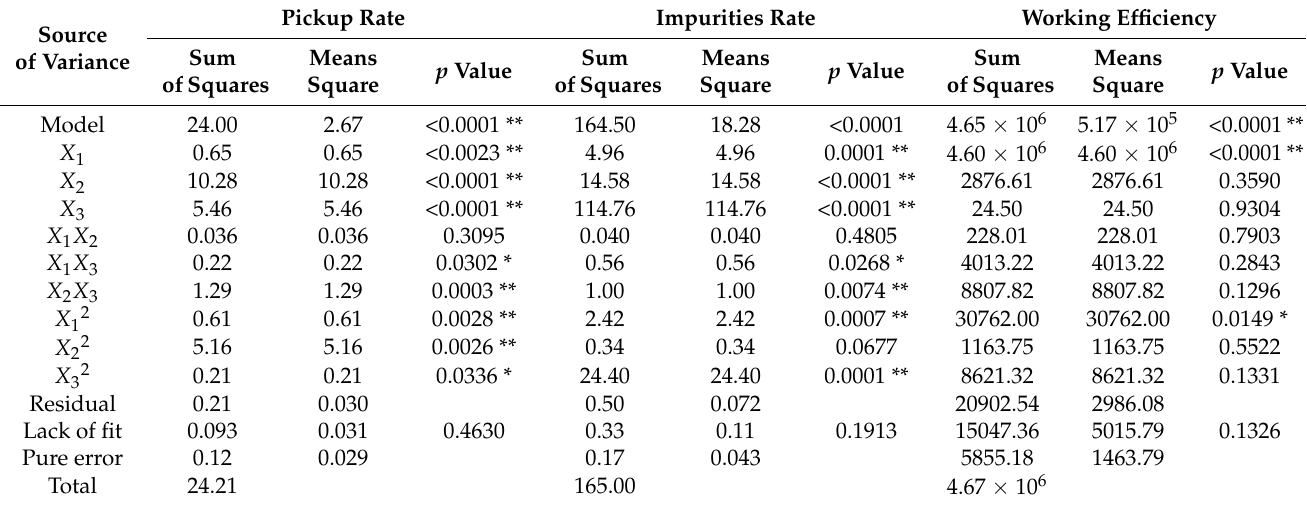
Table 4. The variance analysis for pickup rate, impurities rate, and working